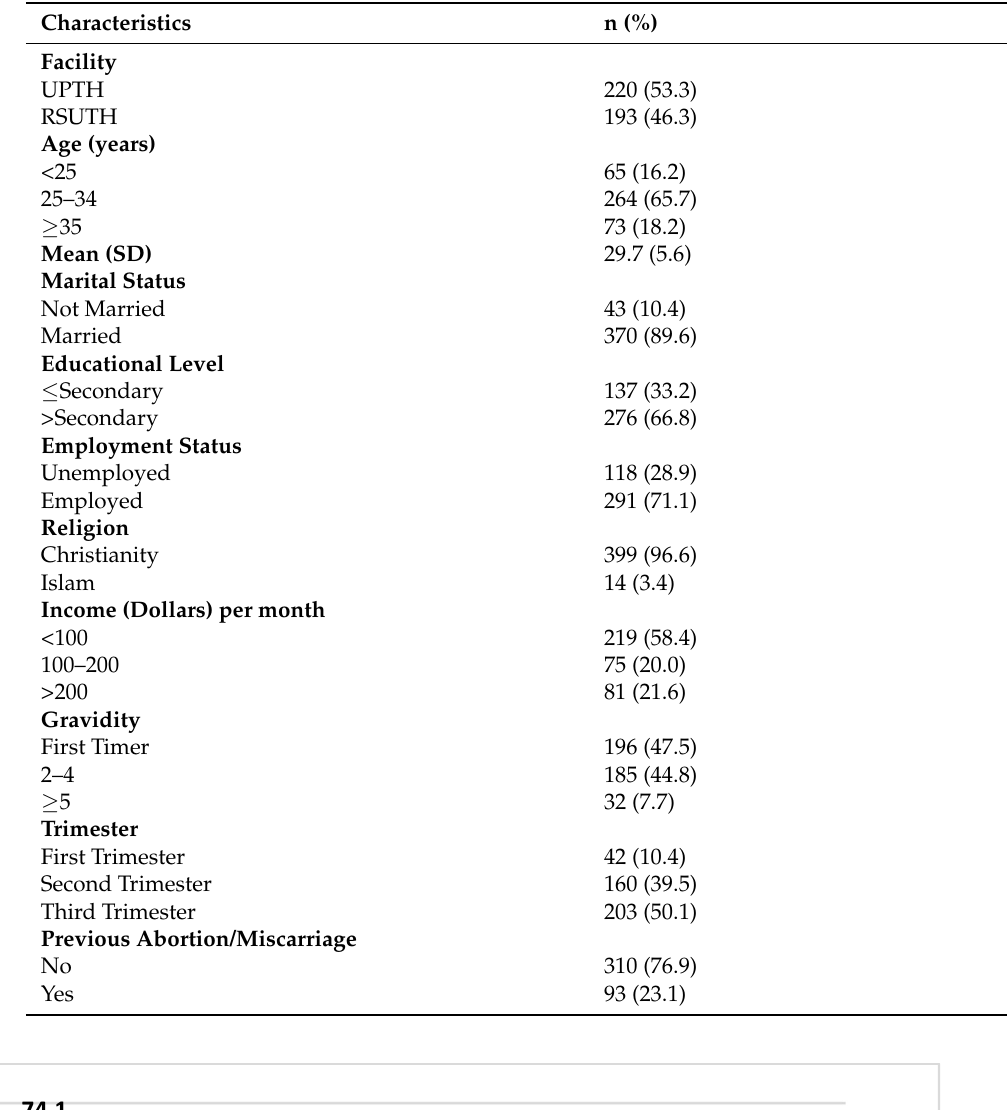
Table 2. Characteristics of the respondents.